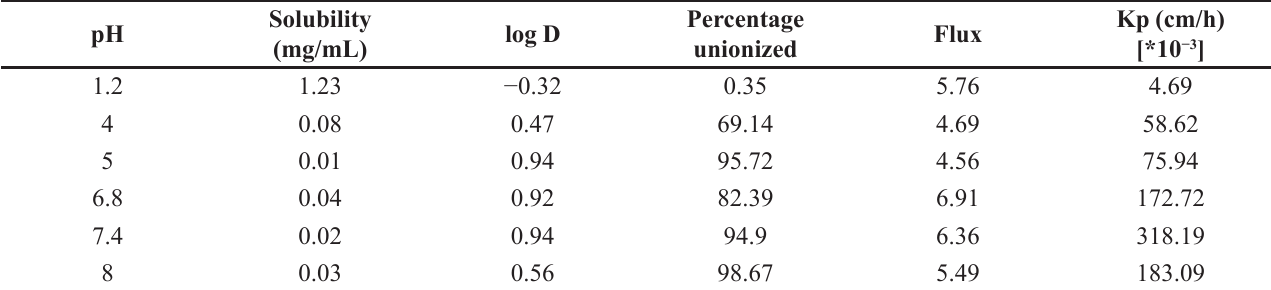
TABLE V - Solubility, distribution coefficient, percentage unionized, and skin permeability parameters of telmisartan